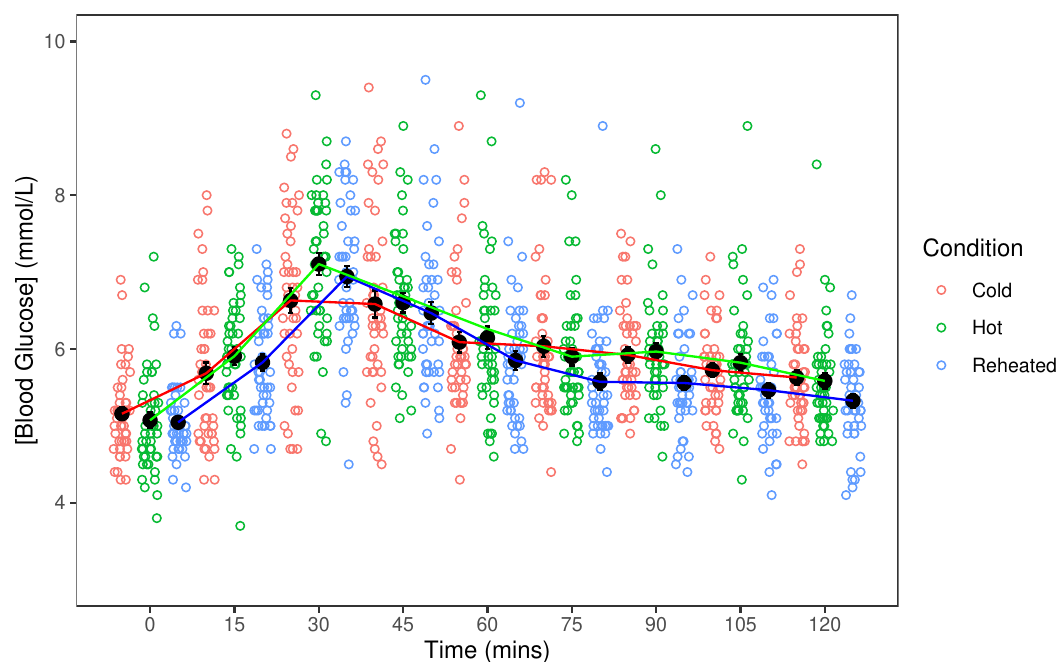
Figure A1. Post-prandial glucose response to either fresh (hot), cold, or reheated pasta. Data shown is mean ± standard error, alongside individual